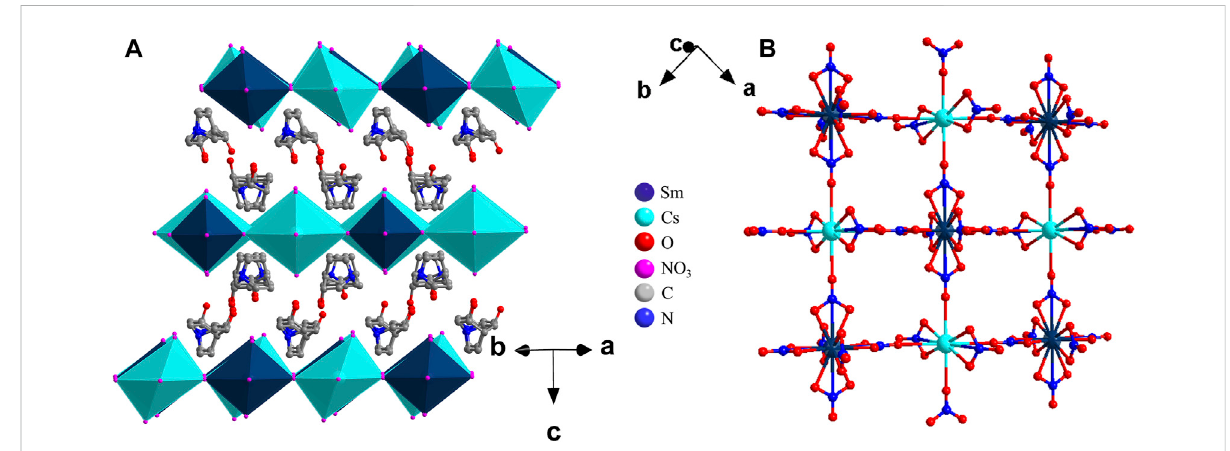
FIGURE 1 Structure packing diagrams (A) and the coordination and connection of atoms of an inorganic anion skeleton layer (B) of 1 at 278